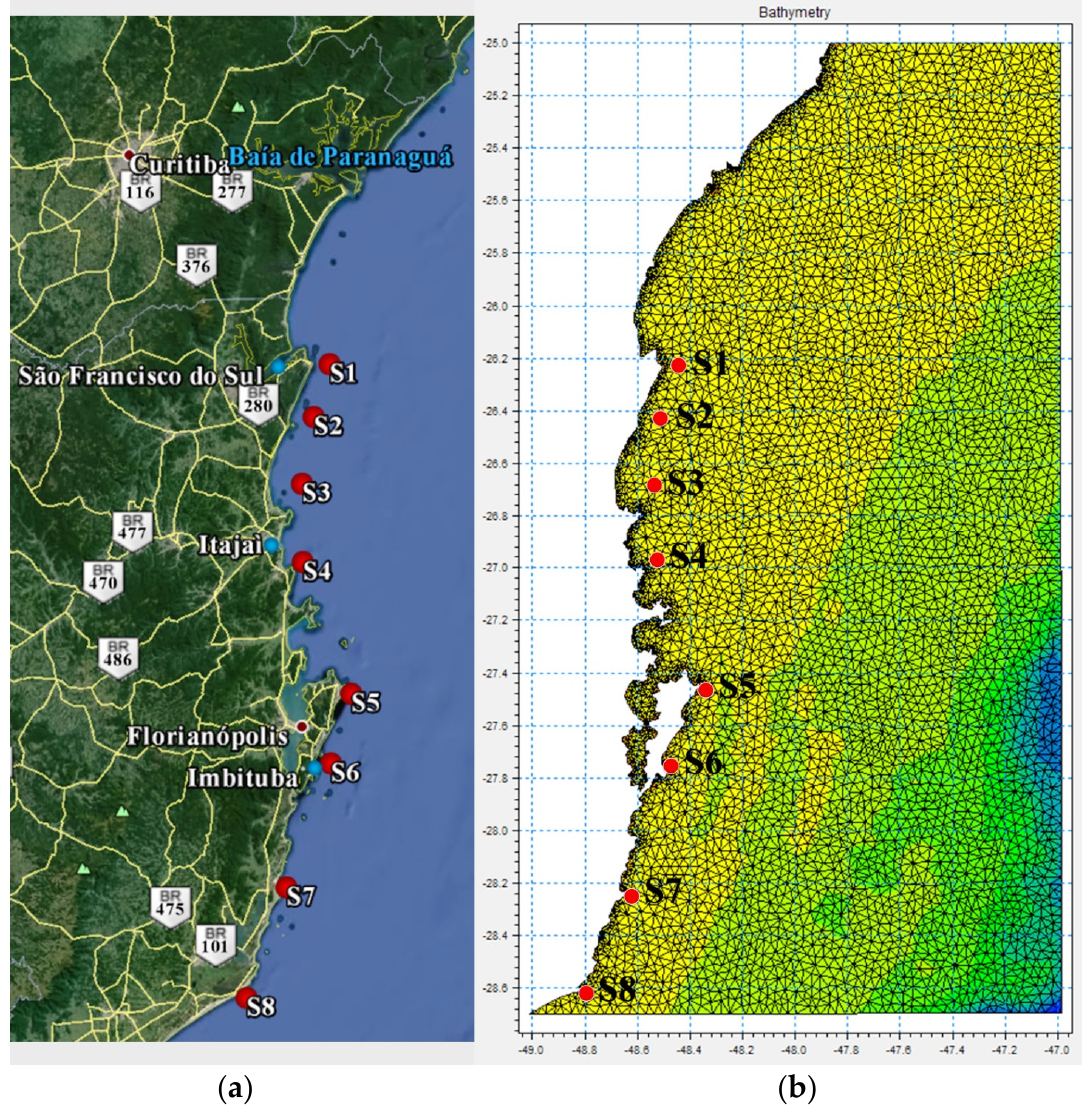
Figure 11. ( a ) Map of Santa Catarina coast showing the location of 8 study sites and the location of ports (light blue points). ( b ) Bathymetry implemented in MIKE 21 SW.